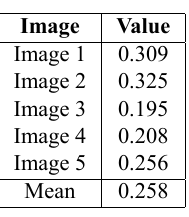
Table 2. Average